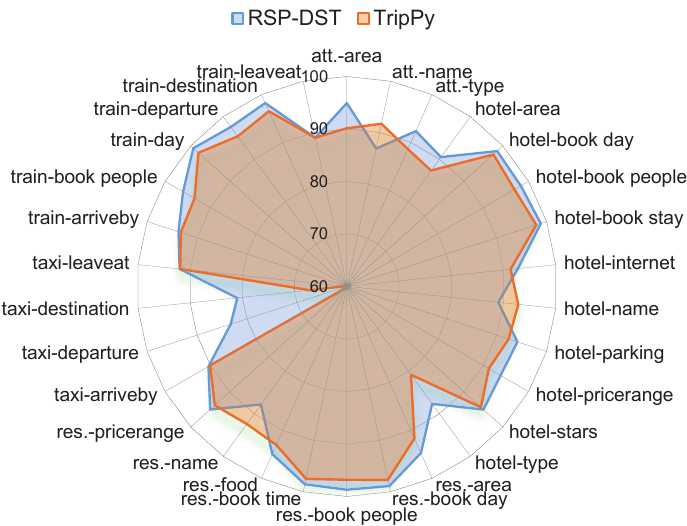
Figure 6. Per-slot accuracy on the test set of MultiWOZ 2.1. In Figure, the “ attraction ” domain is represented as “ att. ” for short and the “ restaurant ” domain is represented as “ res. ”.